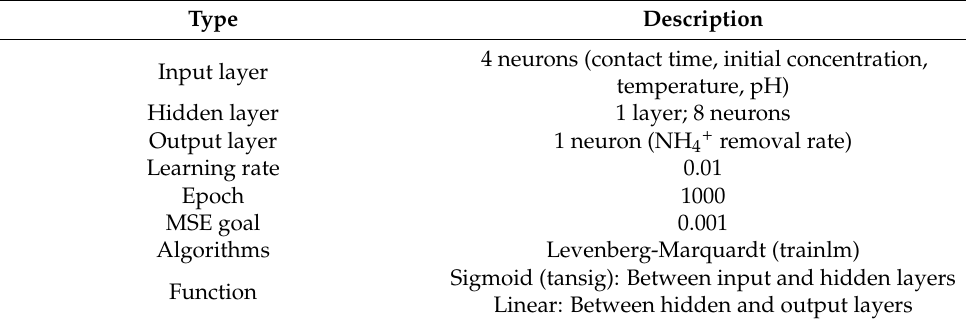
Table 3. Summary of the parameters used in construction of ANN